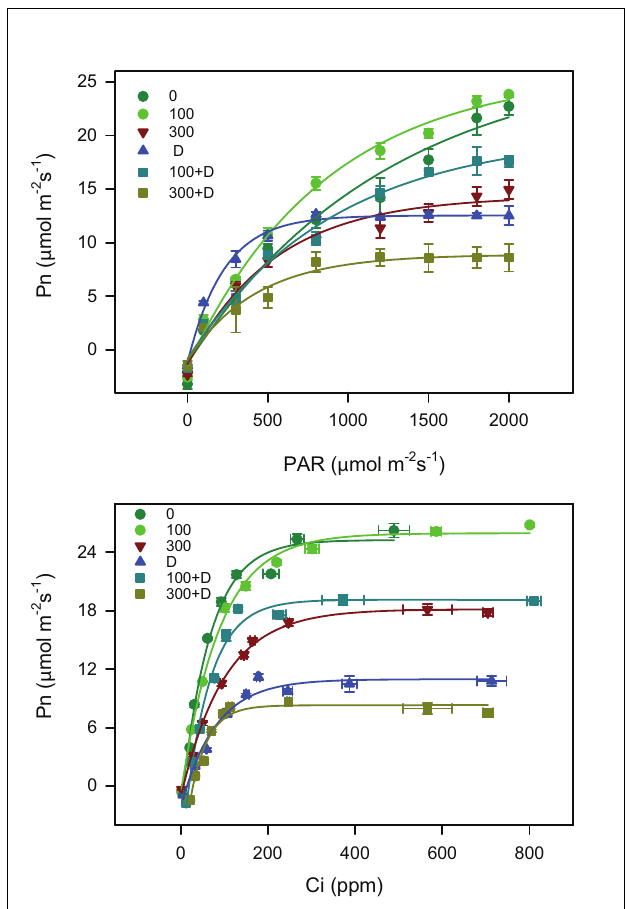
FIGURE 2 | Light response curve ( P n –PAR) and carbon response curve ( P n n– C i ) measurements under salinity, drought, and a combination of both treatments. P n –PAR curve represents the response of net photosynthesis in the range of 0–2000 µ mol m − 2 s − 1 photosynthetic active radiation (PAR) and P n – C i curve indicates the capacity of net photosynthesis under various intercellular CO 2 concentrations (in micromoles per square meter per second) when CO 2 in the air ( C atm ) is in the range of 0–1,500 µ mol m − 2 s − 1 . Values shown are the mean ± SE ( n = 3) under all treatments, as described in